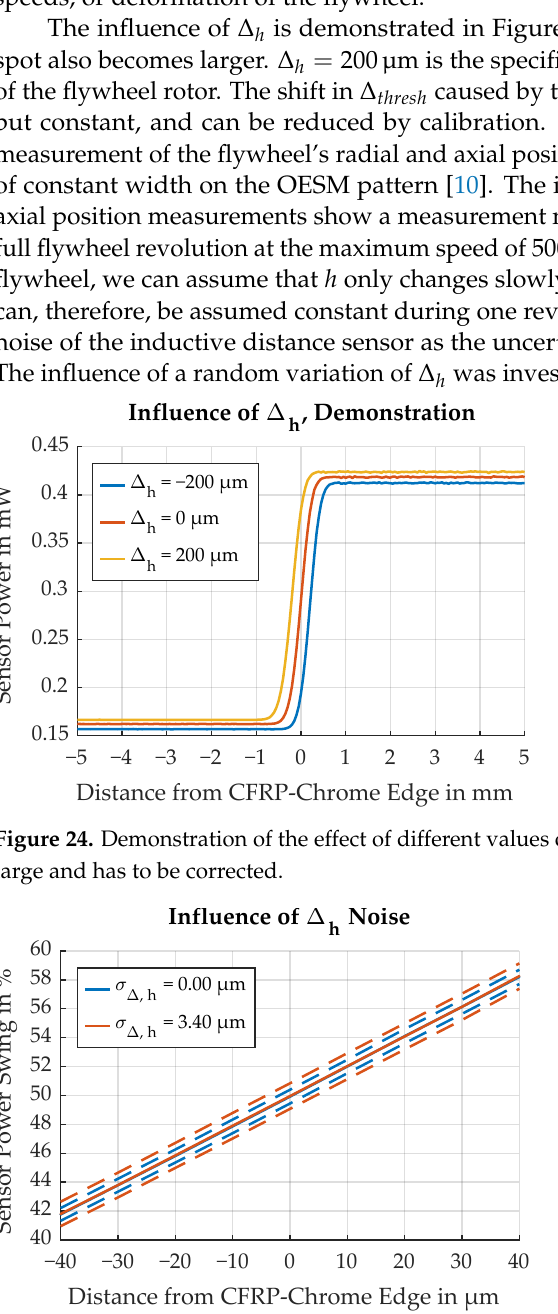
Figure 25. Influence of noise in ∆ h on the threshold position ∆ thresh . Dotted lines represent ± σ